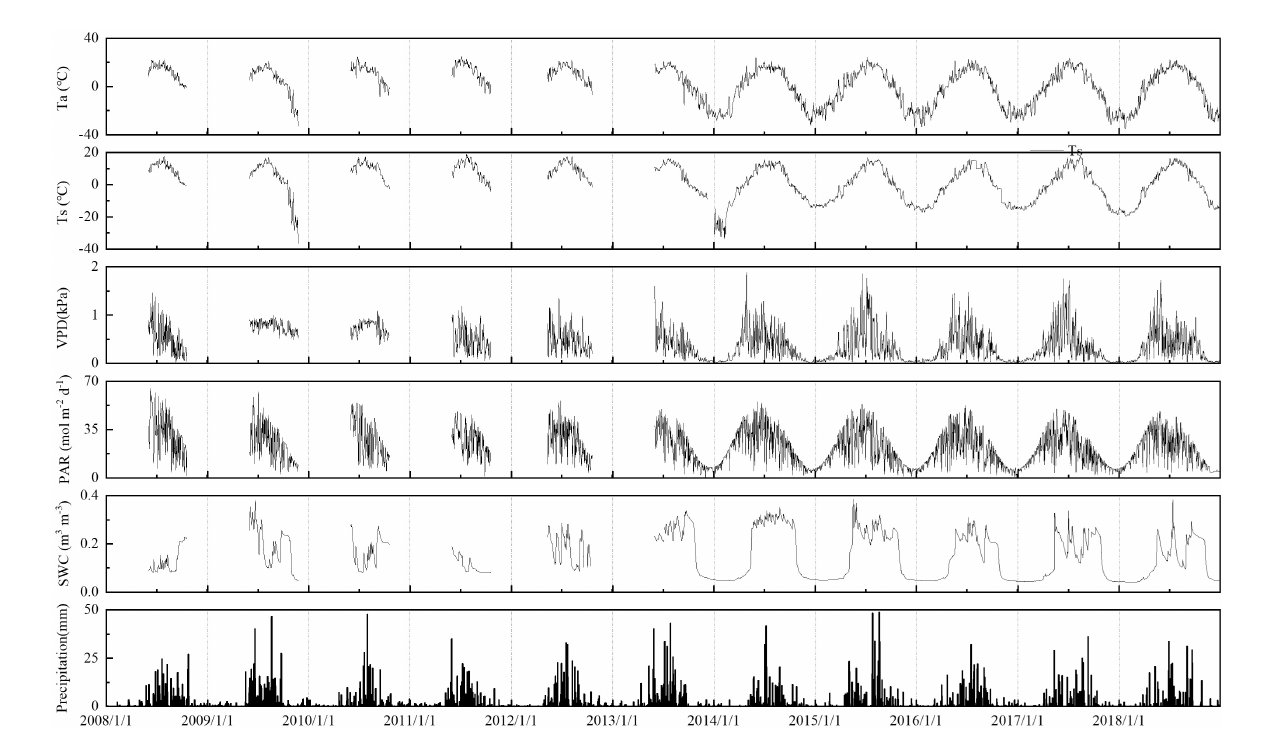
FIGURE 1 Dynamic changes in environmental factors in the boreal forest ecosystem. PAR, photosynthetically active radiation, VPD, vapor pressure de fi cit, T a , air temperature, T s , soil temperature, SWC, volumetric soil water content, PPT,